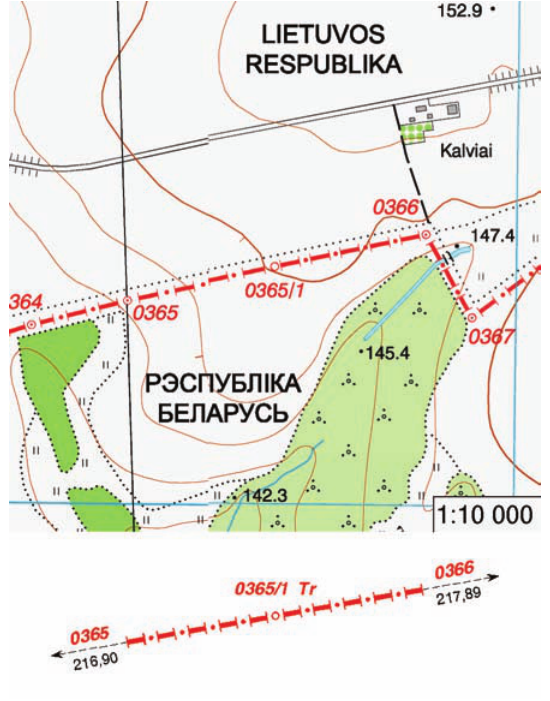
Fig. 1. Concept of the direct visibility lines between the adjacent boundary marks Fig. 3. Representation of the intermediate boundary marks on the boundary map and in the boundary mark protocol Lietuvos ir Baltarusijos valstybių sienos riboje buvo įrengti 86 tarpiniai sienos